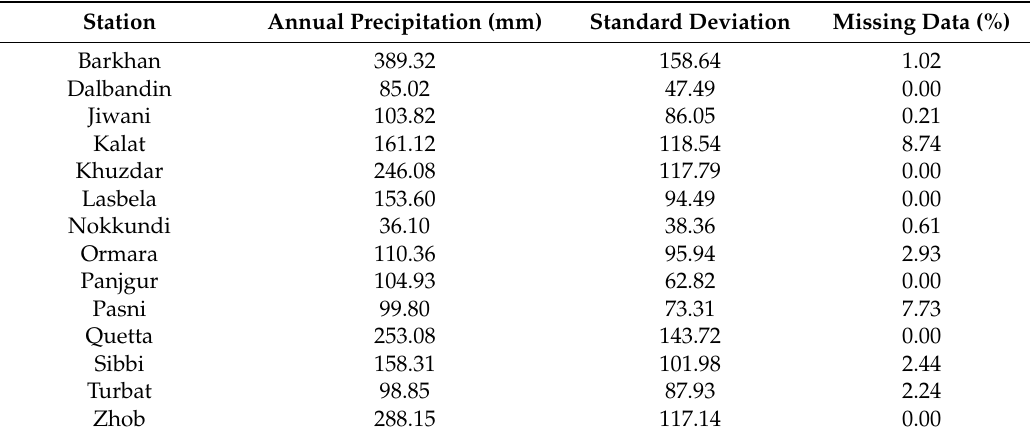
Table 1. Mean and standard deviation of annual precipitation, and the percentage of missing data during 1961 to 2007 at different stations Station Annual Precipitation (mm) Standard deviation Missing Data (%)